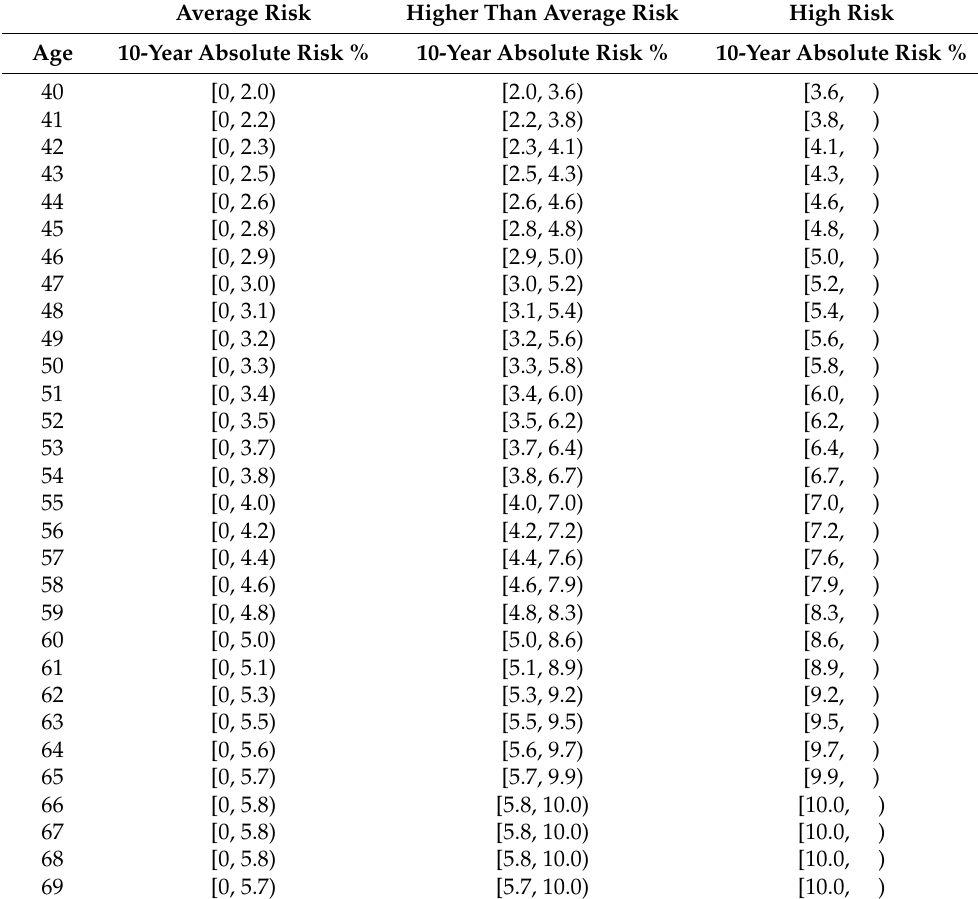
Table 1. Age-specific 10-year absolute risk thresholds for the risk categories—average, higher than average, and high risk for women in Canada